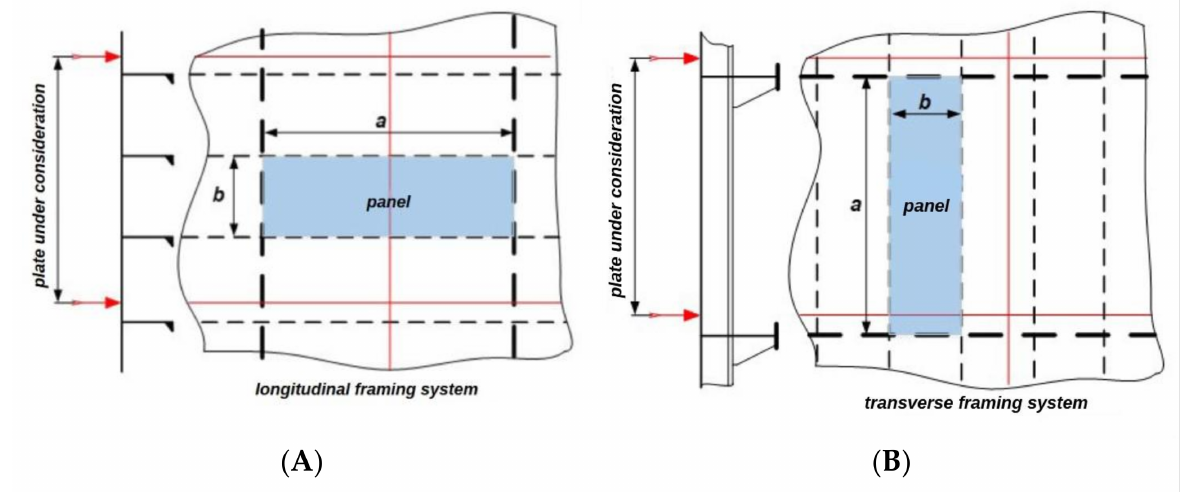
Figure 3. Calculation panels for longitudinal ( A ) and transverse ( B ) framing